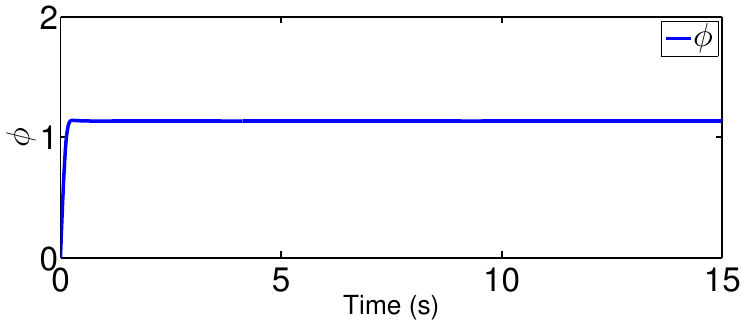
Figure 4. Trajectory of the estimation law φ .